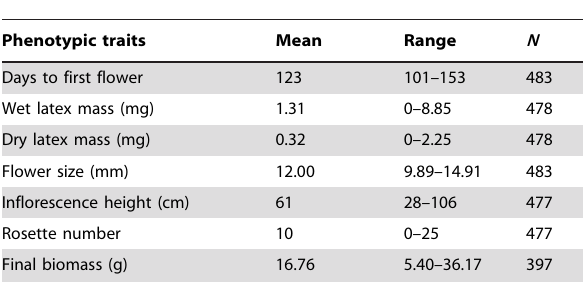
Table 1. Summary statistics for the phenotypic measurements of greenhouse-grown Lobelia siphilitica